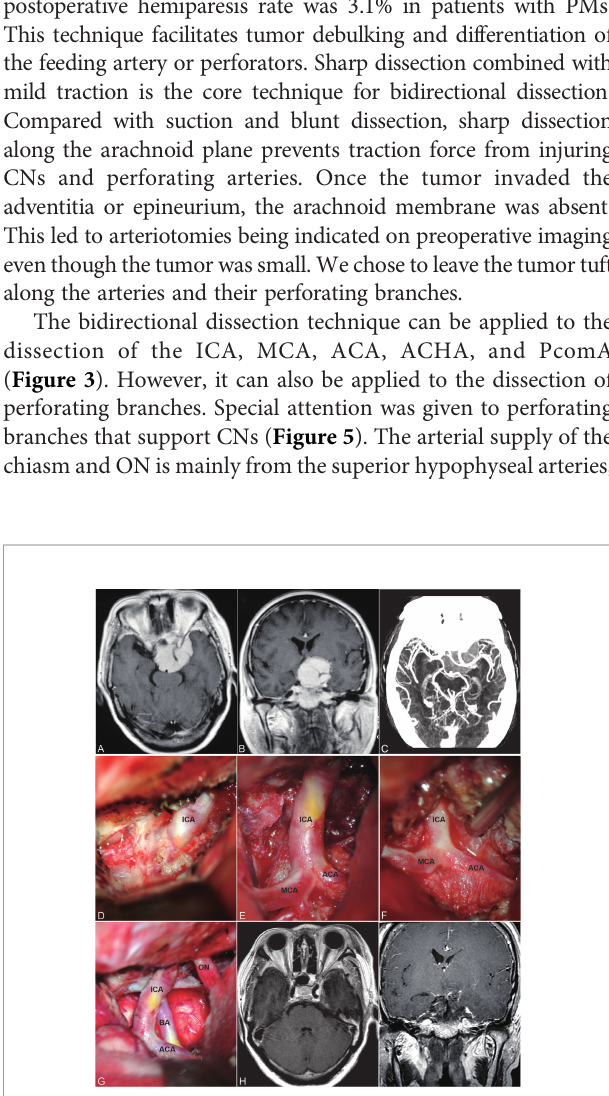
FIGURE 4 | Contrast-enhanced MRI and CTA images of ACM (A – C) preoperative; H, I postoperative) and steps of bidirectional dissection technique (D – G) . Intradural localization of the ICA (D) and dissection along the course of ICA and its branches (E, F) to achieve total resection while preserved the ICA and its branches (G)